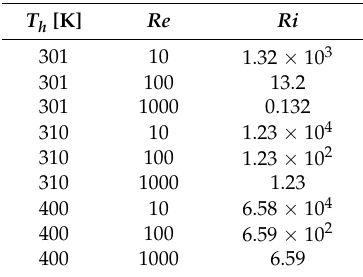
Table 4. Hot wall Temperatures T h and Richardson and Reynolds numbers, Ri and Re , respectively.